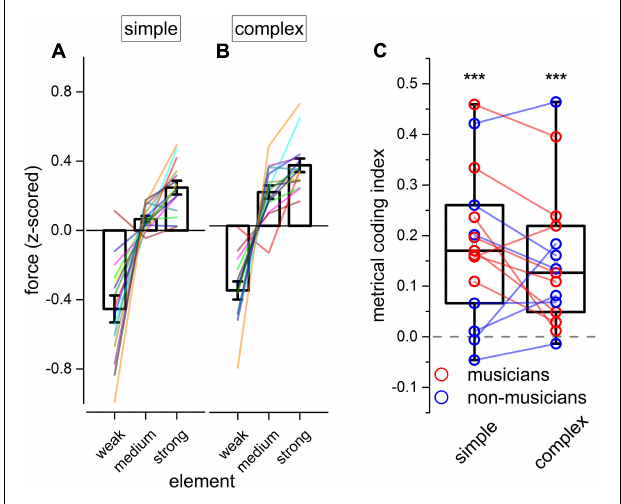
FIGURE 4 | Experiment 2: reproduction force. (A,B) Grand-average force profile of the finger-tapping for the different elements of a simple (A) and complex sequence (B) . Error bar indicates ± 1 S.E.M. Colored lines show single participants. (C) Boxplot showing the metrical coding index distribution for both simple and complex sequences. Dots indicate individual data (musicians are marked in red, and non-musicians in blue); error bar indicates confidence intervals (95 %ile). Asterisks mark the statistical significance ( p -value): *** < 0 .